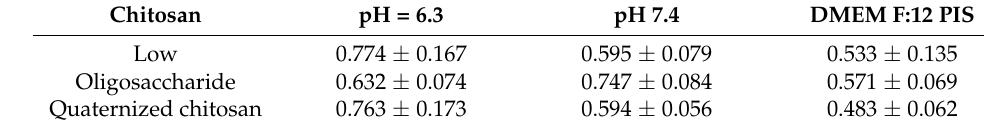
Table 2. Polydispersity index values for each of the nanogels at different media. Chitosan pH = 6.3